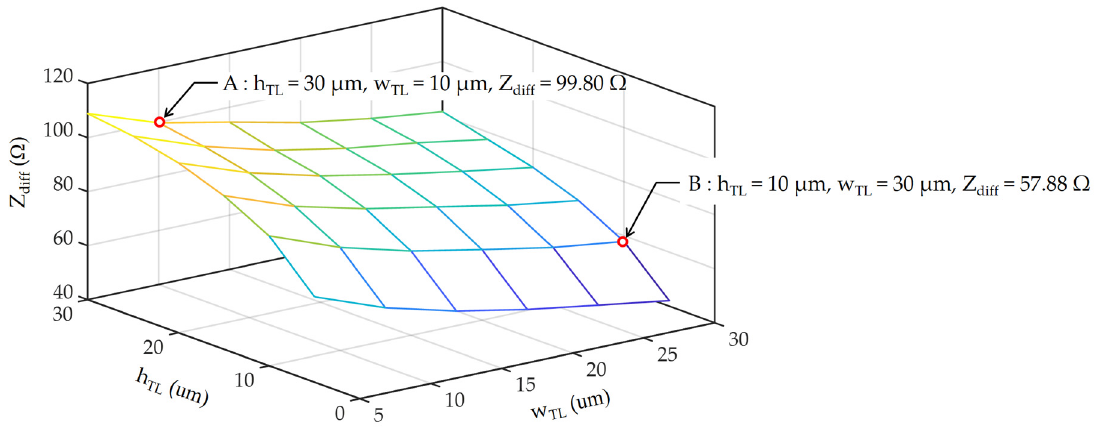
Figure 9. Example of design-space exploration using the rapid and efficient CVDDM.